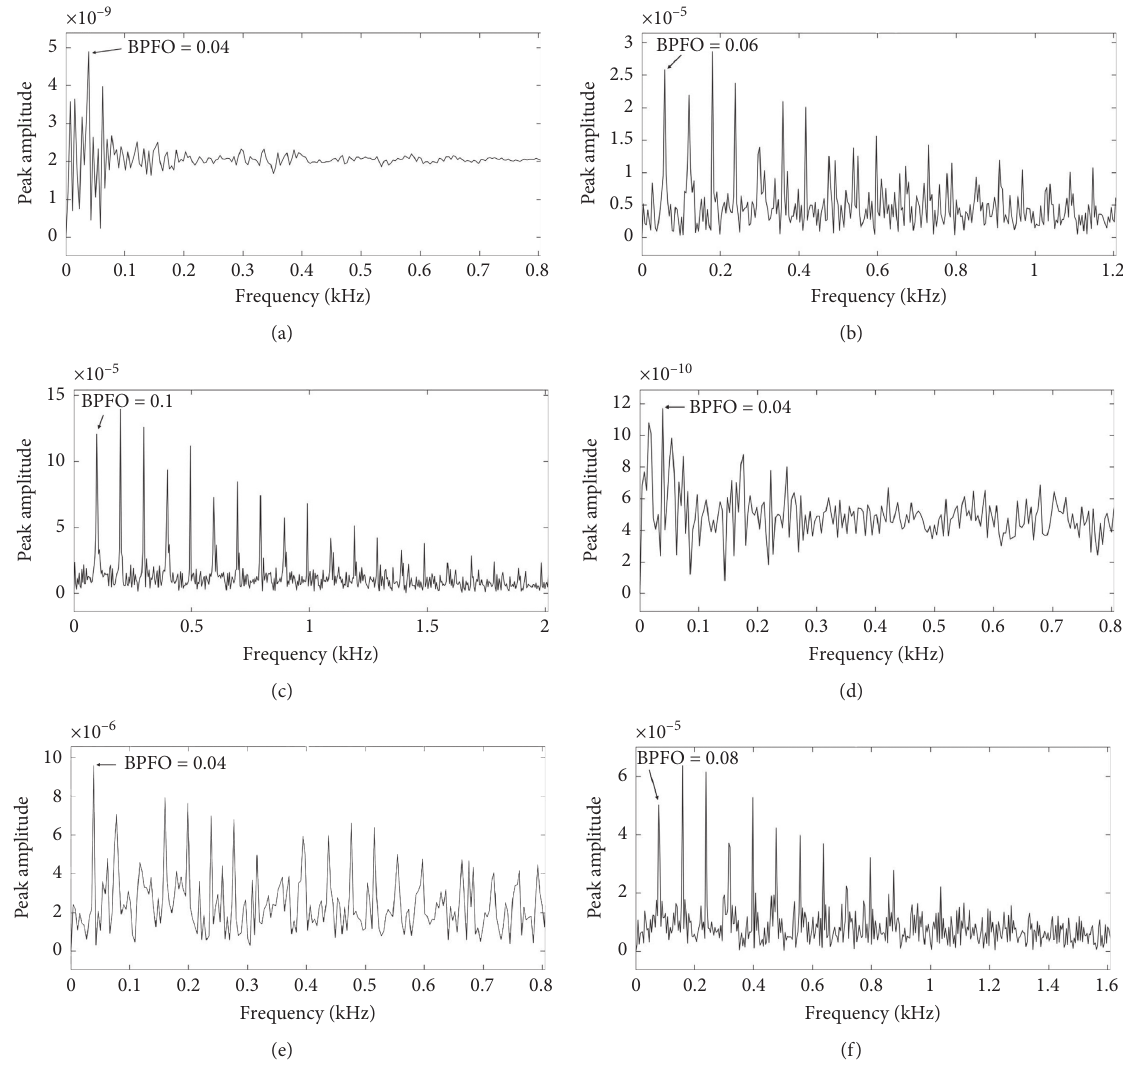
Figure 13: Envelope spectrum of signals after denoising. (a) Small defect, small load, and 600rpm. (b) Small defect, medium-low load, and 900rpm. (c) Small defect, medium-high load, and 1500rpm. (d) Large defect, small load, and 600 rpm. (e) Large defect, medium-high load, and 600rpm. (f) Large defect, high load, and